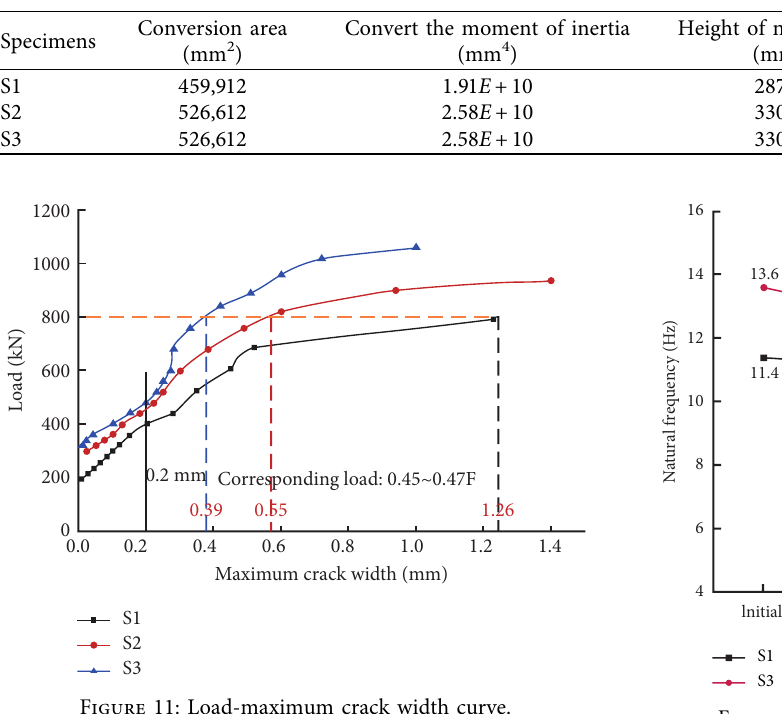
Table 3: The calculation results of cracking load.